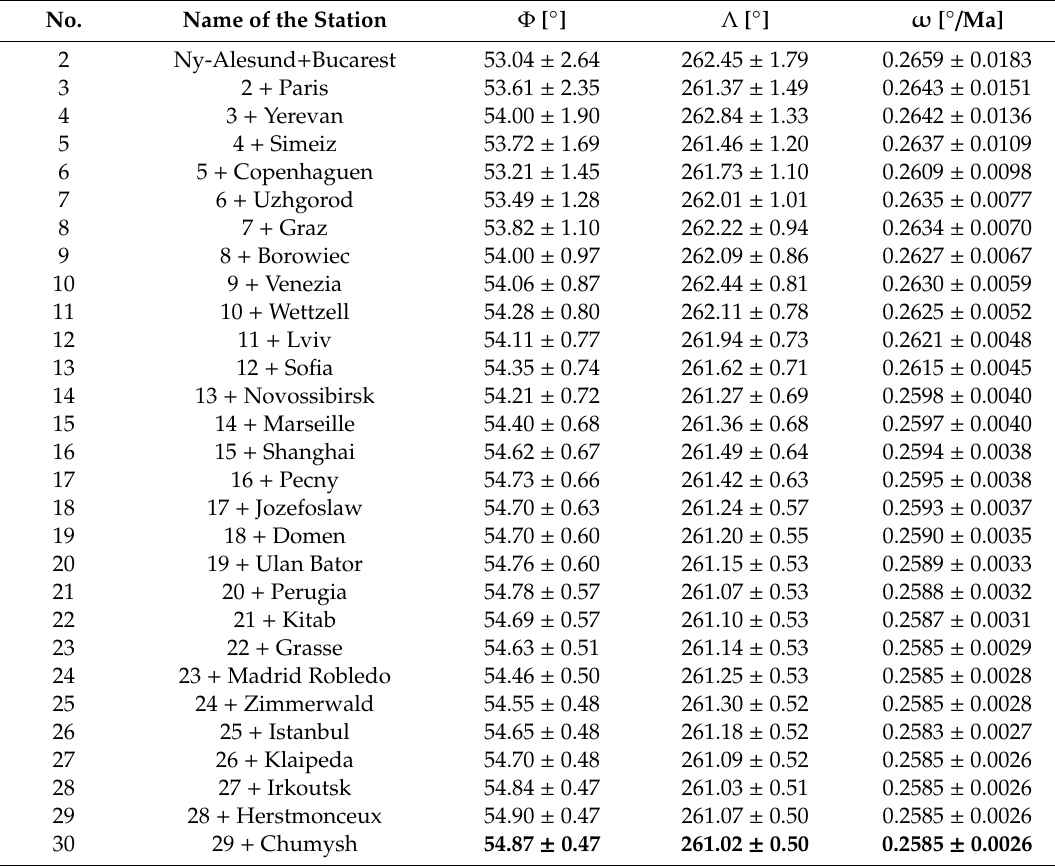
Table A1. Computed plate motion parameters, and their errors, of the Eurasian plate for the GNSS network using the sequential method. Scenario 1 of the calculations.